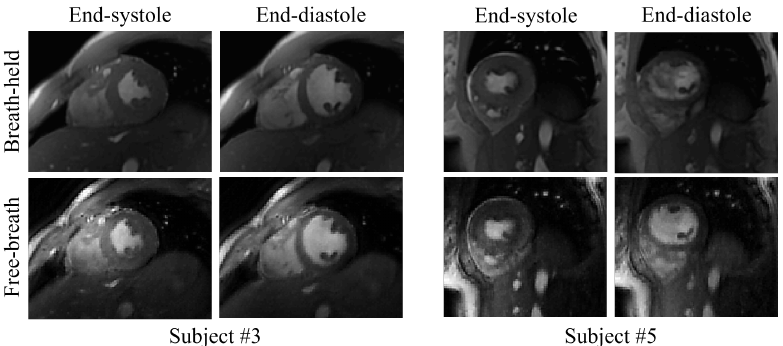
Figure 5. Visual comparison of the reconstructed free-breathing images and the fully-sampled breath- hold images acquired using FGRE sequence. For each subject, we acquired fully-sampled breath-hold images for one middle slice using the FGRE sequence. End-systolic and end-diastolic phases from two slices from two subjects are shown in the